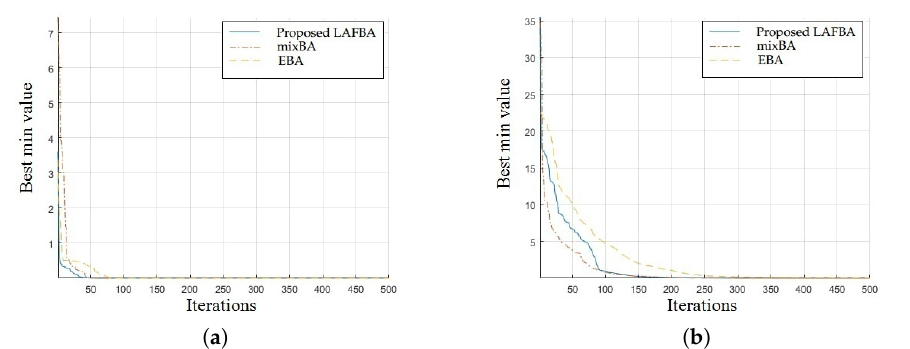
Figure 7. ( a ) Weierstrass function convergence graph. ( b ) Zakharov function convergence